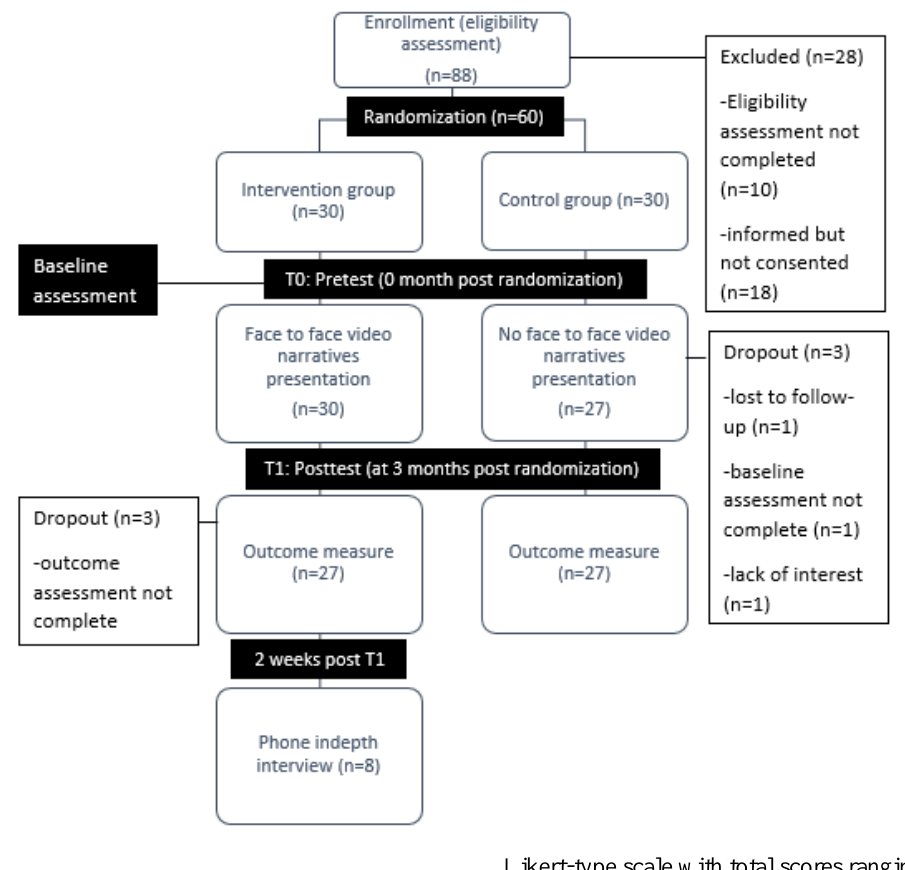
Figure 1. CONsolidated Standards Of Reporting Trials (CONSORT) flowchart of poststroke patients throughout the